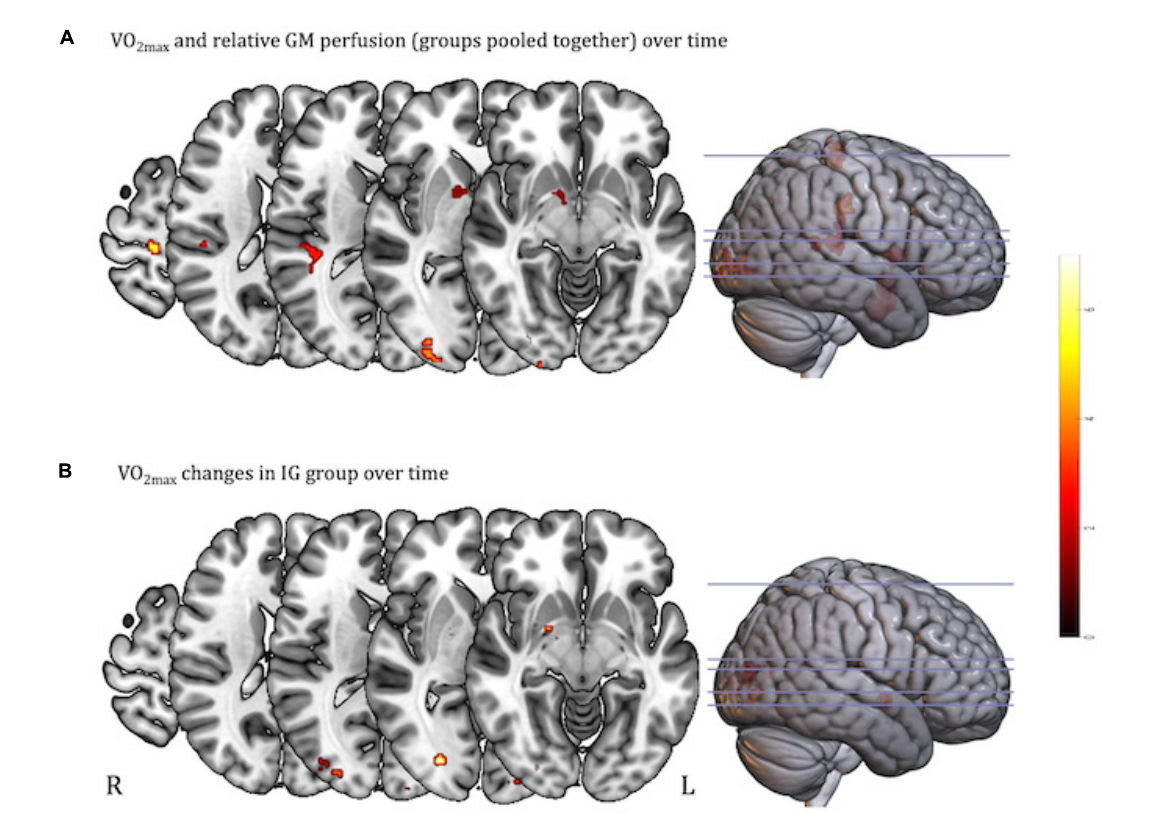
FIGURE4 Regression analysis between VO 2max and relative gray matter (GM) perfusion using the 3dlmer model in AFNI [ p < 0.001 (uncorrected), cluster corrected at alpha = 0.05 with cluster size ( > 42 voxel) for FWE]. (A) Higher VO 2max associated with higher relative GM CBF is shown in right STG, right middle occipital region, right precentral gyrus, and right ventral striatum (groups pooled together); (B) regression analysis for IG only showing higher VO 2max associated with higher relative GM CBF in the bilateral middle occipital region, as well as a trend in the right ventral striatum (displayed at the more liberal threshold of p < 0.005, uncorrected, > 10 voxel). Clusters are overlaid on the structural MNI template of the brain. The color bar from dark red to light yellow indicates the increasing strength of the correlation between VO 2max and relative GM perfusion